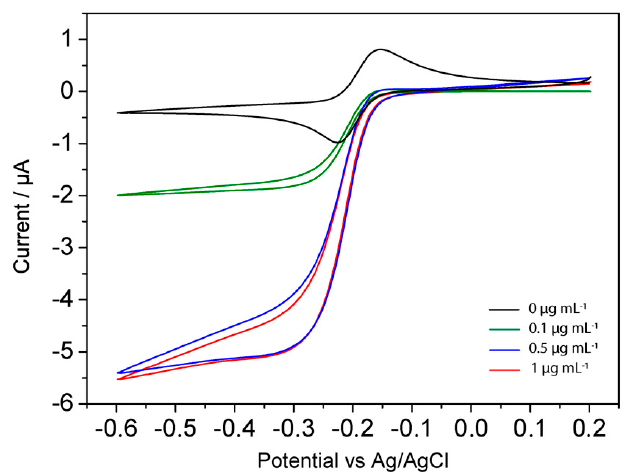
Figure 6. Cyclic voltammograms recorded with the NEA incubated with different concentrations of gliadin (0, 0.1, 0.5, and 1 µg mL − 1 ) obtained in 0.1 mM MB in presence of 1.5 mM H 2 O 2 . Scan rate, 50 mV s − 1 ; supporting electrolyte, 0.1 mM MB in 0.01 M PBS; and pH 7.2.